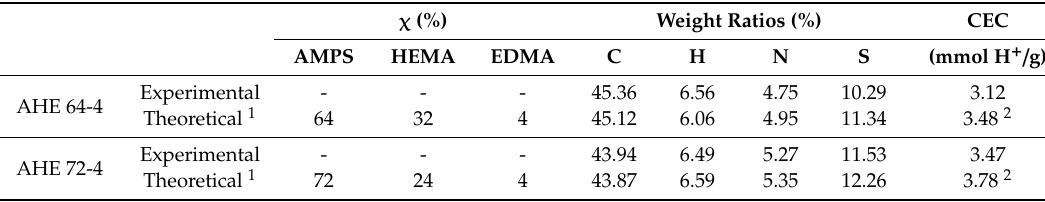
Table 1. The expected molar composition of the AHE materials.